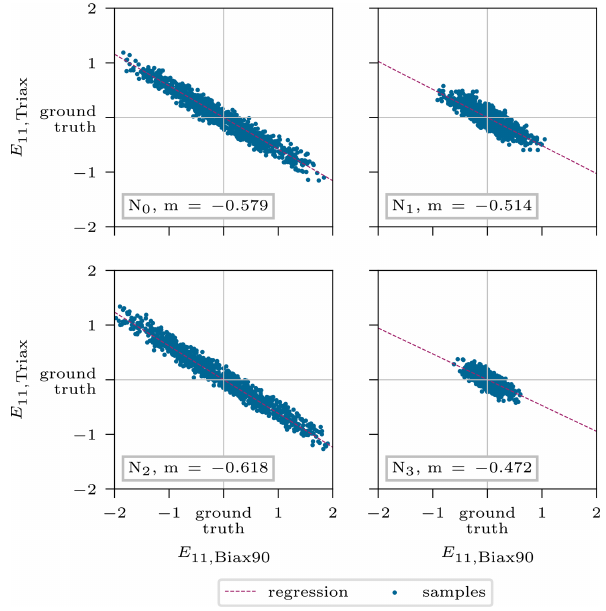
Figure 11. Interaction of stiffness E 11 , Biax90 and E 11 , Triax de- scribing the intrinsic model ambiguities. The depicted values cor- respond to the standardized mean posterior prediction for the 5000 test samples.